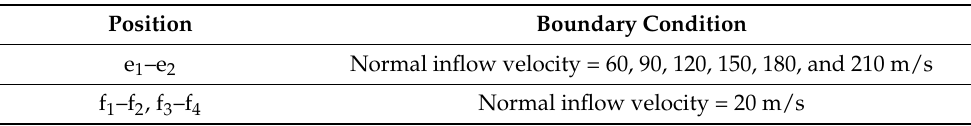
Table 2. Boundary